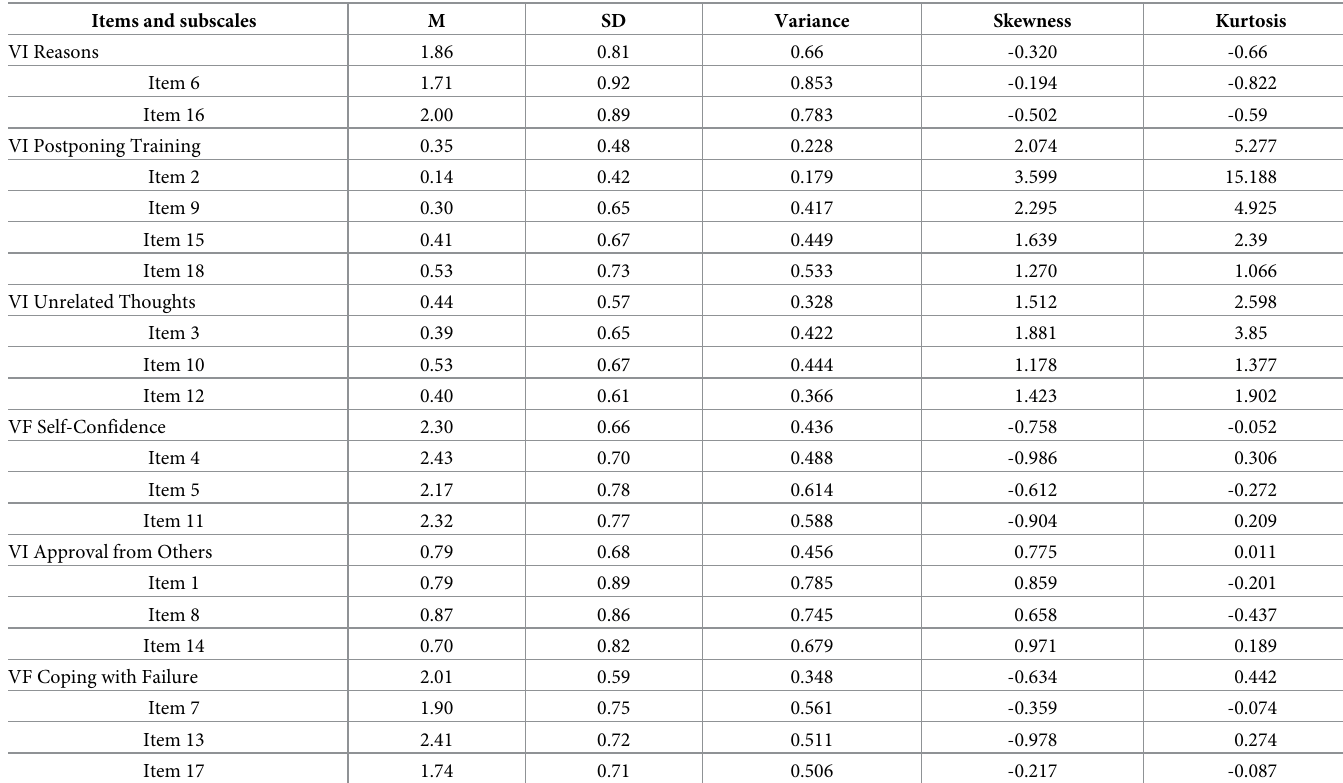
Table 1. Main statistical descriptors of the items and subscales.